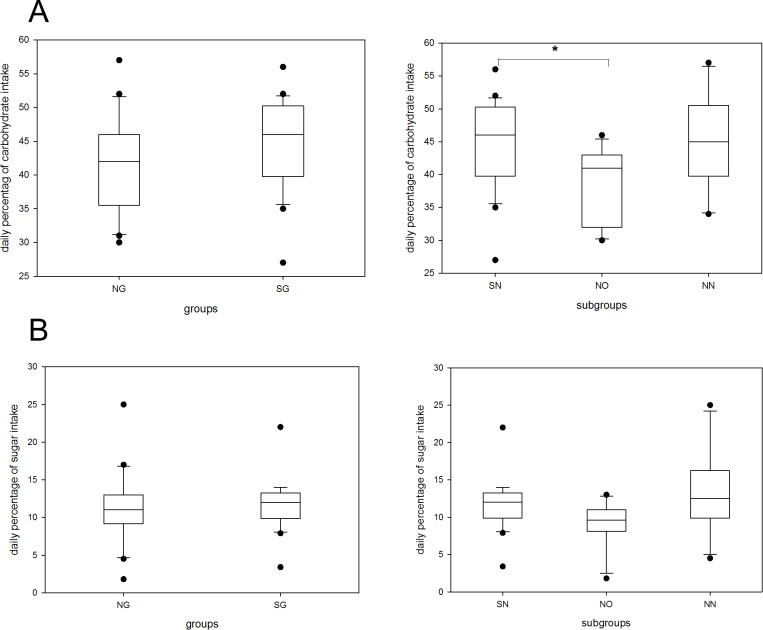
Daily carbohydrate (A) and sugar (B) intake by groups and subgroups. Carbohydrate (A) and sugar intake (B) as illustrated in percent. The boxes cover the first quartile on the bottom and the third quartile on the top. Whiskers reach from the minimum to the maximum value excluding outliers (illustrated by dots). Shift-working group and shift-working nursing-staff subgroup cover identical cohorts. NG, non-shift-working group; SG, shift-working group; SN, shift-working nursing-staff subgroup; NO, non-shift-working office-staff subgroup; NN, non-shift-working nursing-staff subgroup *p<0.05.